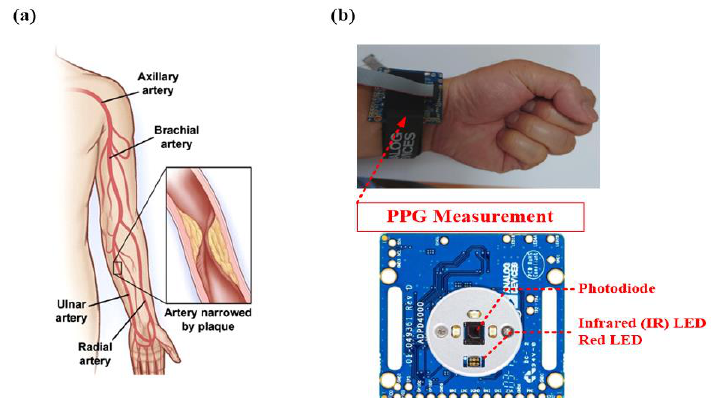
Figure 1. Wrist-based photoplethysmography (PPG) measurement tool for detecting UEVD. ( a ) Narrowed arteries (stenosis) in the upper limb, ( b ) Wrist-based PPG measurement tool